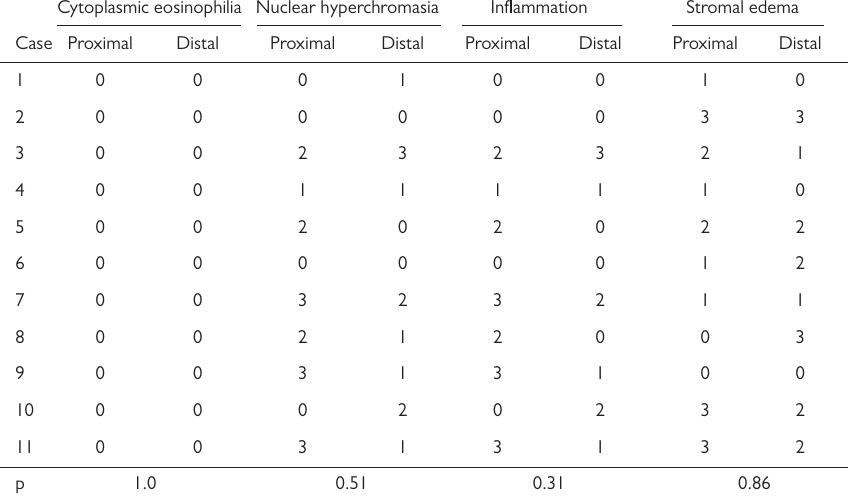
Table 1. Histopathological assessment results of the sural nerve